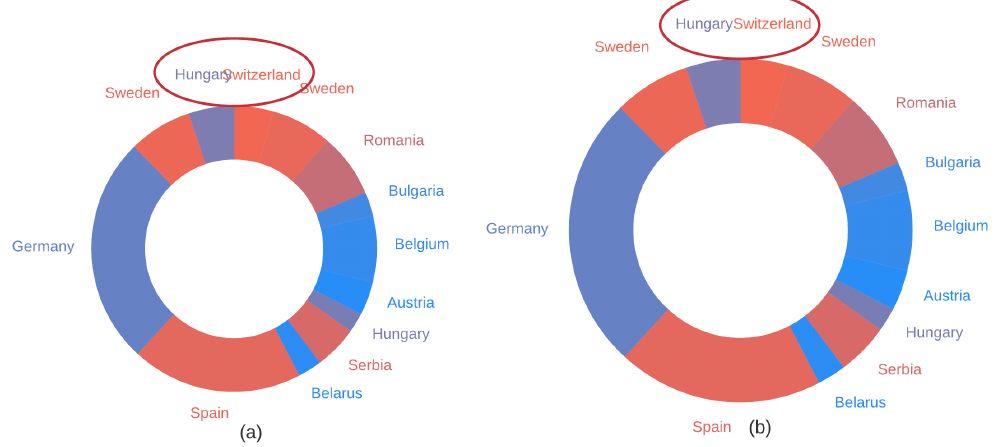
Figure 9. Interaction: semantic zoom , ( a ) before use; ( b ) after use.